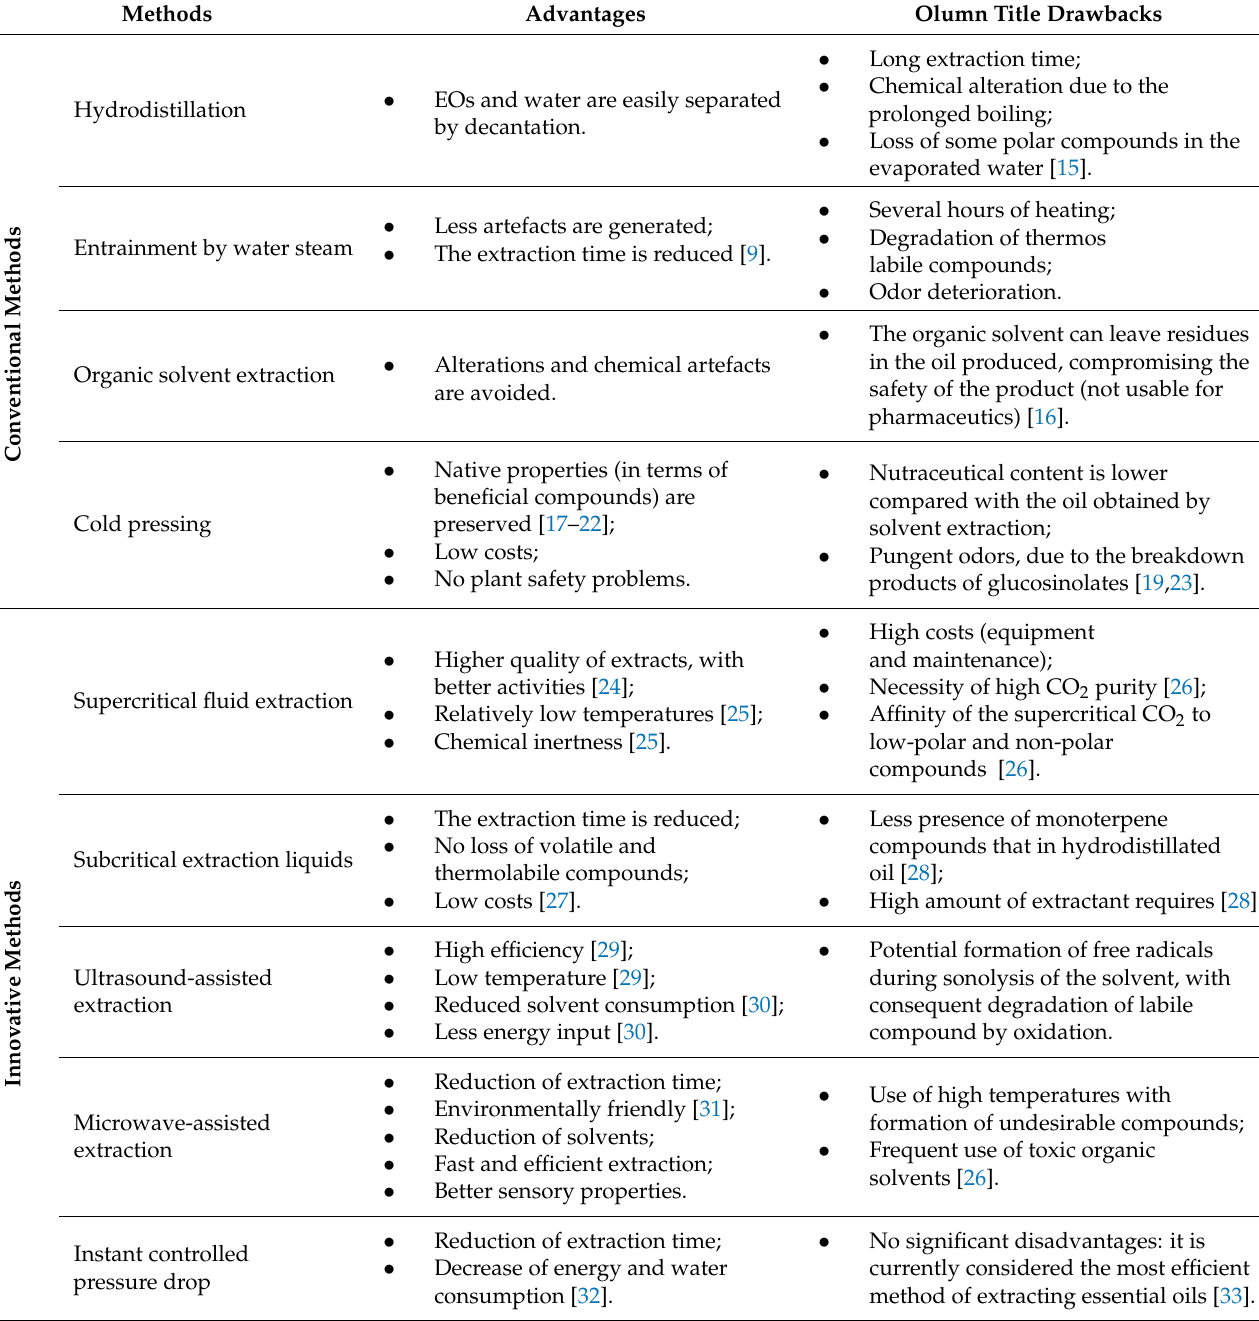
Table 1. Advantages and drawbacks of different essential oils (EOs) extraction